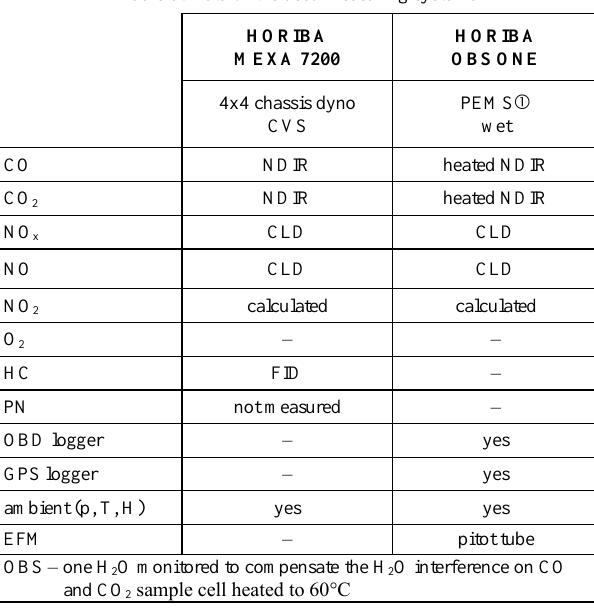
Table 3. Data of the used measuring systems